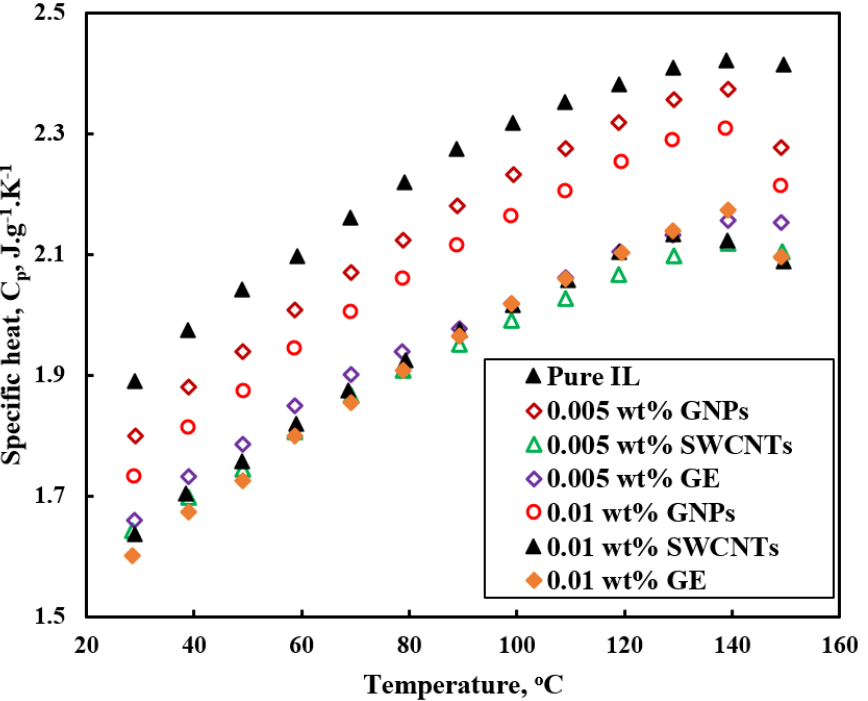
Figure 5. Variation of specific heat of [C 4 mim][BF 4 ] and the ILs-based nanofluids containing different carbon nanomaterials at the mass fractions of 0.005% and 0.01% as a function of temperature [52]. Reproduced with permission from [Zhang], [Renew. Energy]; published by [Elsevier], 2016.